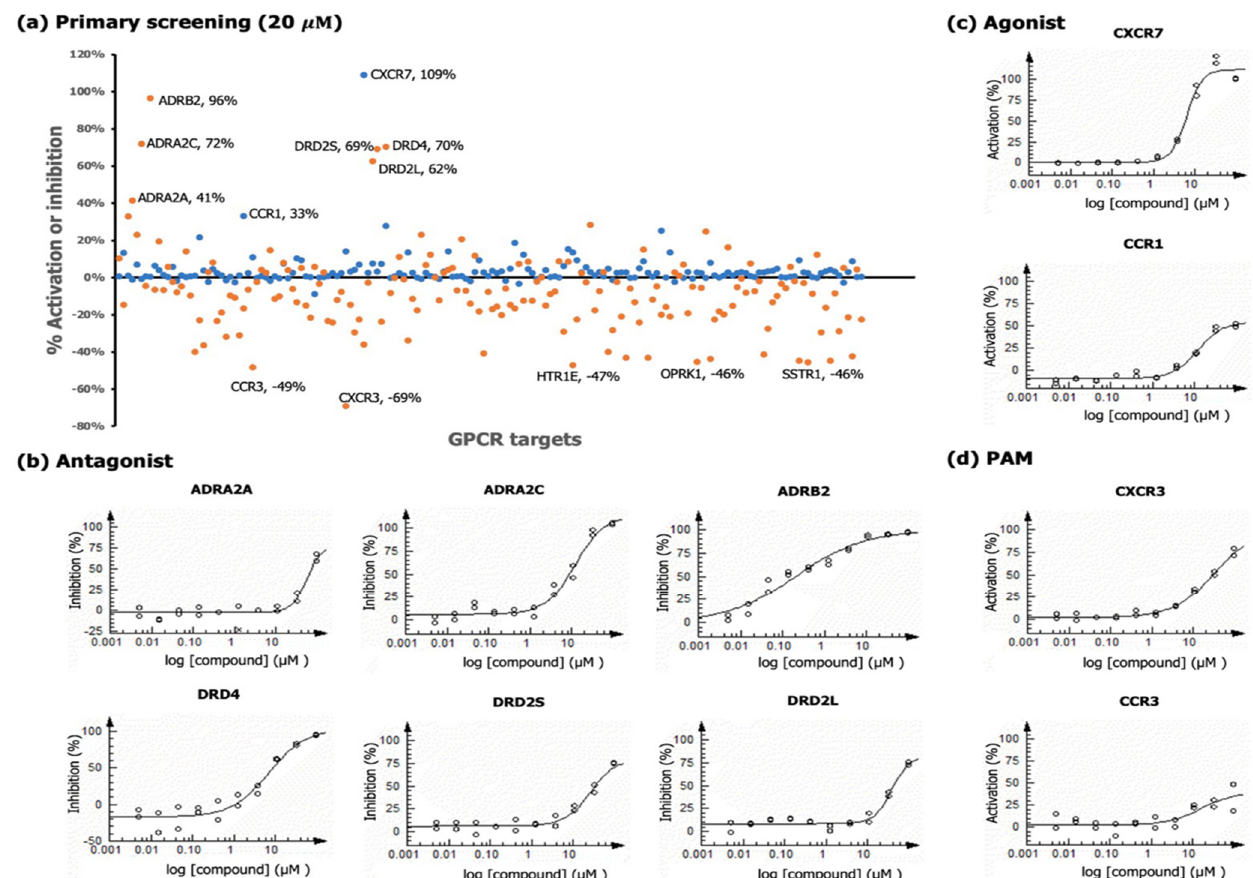
Figure 3. GPCR profiling of aaptamine using cell-based PathHunter β -arrestin assays under agonist and antagonist modes at 20 µ M final concentration. Compound % activation or inhibition is calculated relative to basal and maximal activity values obtained through treatment of corresponding target ligand (100% at EC 80 ). ( a ) Primary screening results shown in scatterplot against a panel of 168 GPCRs. The hits identified with >30% activation and >35% inhibition are labeled. ( b ) Dose-response curves of aaptamine in antagonist mode against confirmed hits: ADRA2A (IC 50 56.1 µ M), ADRA2C (IC 50 11.9 µ M), ADRB2 (IC 50 0.20 µ M), DRD4 (IC 50 6.9 µ M), DRD2L (IC 50 38.7 µ M), and DRD2S (IC 50 25.7 µ M). Yohimbine HCl (IC 50 0.091 µ M), UK 14,304 (IC 50 1.5 × 10 − 3 µ M), ICI 118,551 (IC 50 3.9 × 10 − 4 µ M), Risperidone (IC 50 0.022 µ M), Risperidone (IC 50 1.8 × 10 − 3 µ M), and Risperidone (IC 50 0.022 µ M) were the ligands used as positive controls for ADRA2A, ADRA2C, ADRB2, DRD4, DRD2L, and DRD2S, respectively. ( c ) Dose-response curves of aaptamine in the agonist mode against confirmed hits: CXCR7 (EC 50 6.2 µ M) and CCR1 (EC 50 11.8 µ M). CXCL12 (EC 50 9.6 × 10 − 3 µ M) and CCL13 (EC 50 0.026 µ M) were the ligands used as positive controls, respectively. ( d ) Dose-response curves of aaptamine in positive allosteric modulation (PAM) against CCR3 (EC 50 16.2 µ M) and CXCR3 (EC 50 31.8 µ M). The control agonist was added at EC 20 to determine superactivation in the presence of low levels of agonists. CCL3 (EC 50 3.0 × 10 − 3 µ M) and CXCL11 (EC 50 6.7 × 10 − 3 µ M) were the ligands used as positive controls, respectively. Data are presented as mean ± SD (n =